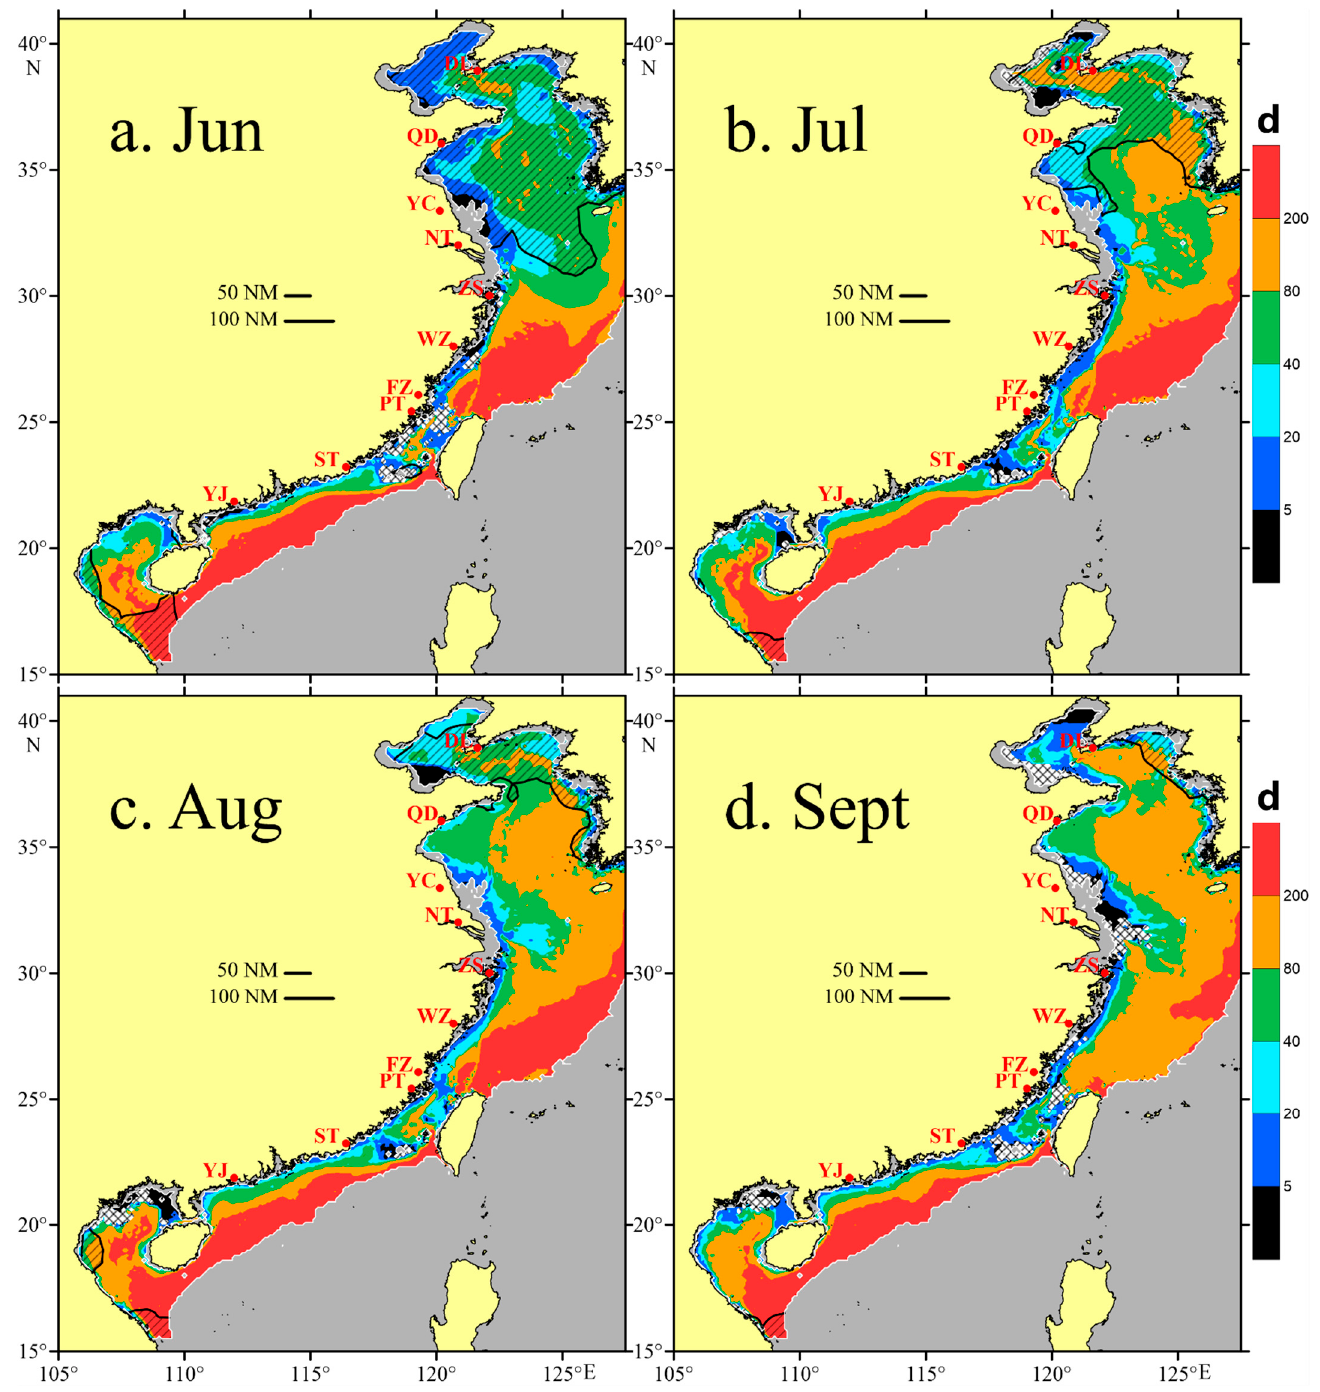
Figure 9. Distribution of the days of the background ocean stratification destroyed (d) in the waters adjacent to China. The two horizonal black bars indicate reference lengths of 50 NM and 100 NM, respectively. The regions covered by slashes are of wind speed less than 5 m/s. The crosshatching indicates the regions without stratification.